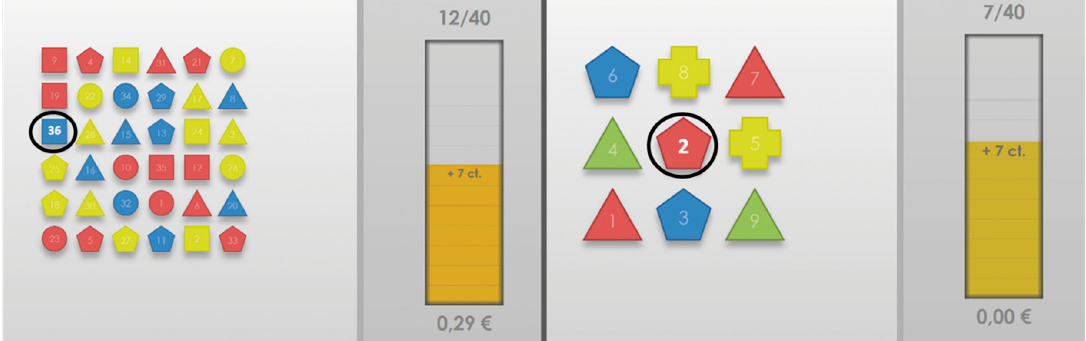
Figure 1. The visual search task on the example of Overload ( left ) and Underload ( right ) induction scheme. The user has to spot the single unique object. The correct answers are 36 for Overload (unique blue and square object) and 2 for Underload (unique red and pentagon object).